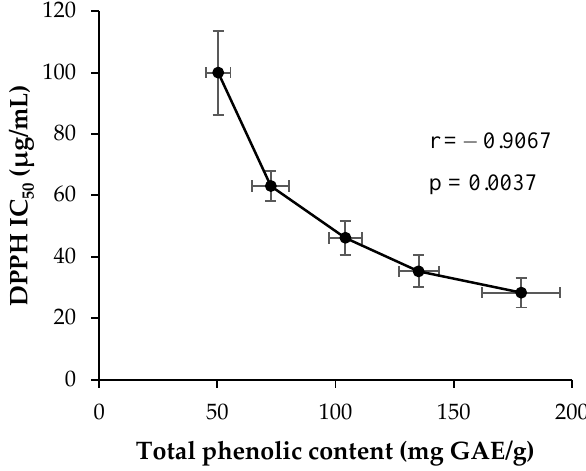
Figure 4. E ff ects of temperature on the DPPH IC 50 of black tea. Figure 4. Effects of temperature on the DPPH IC 50 of black tea. Table 1. Effects of temperature on the total phenolic content of black tea.